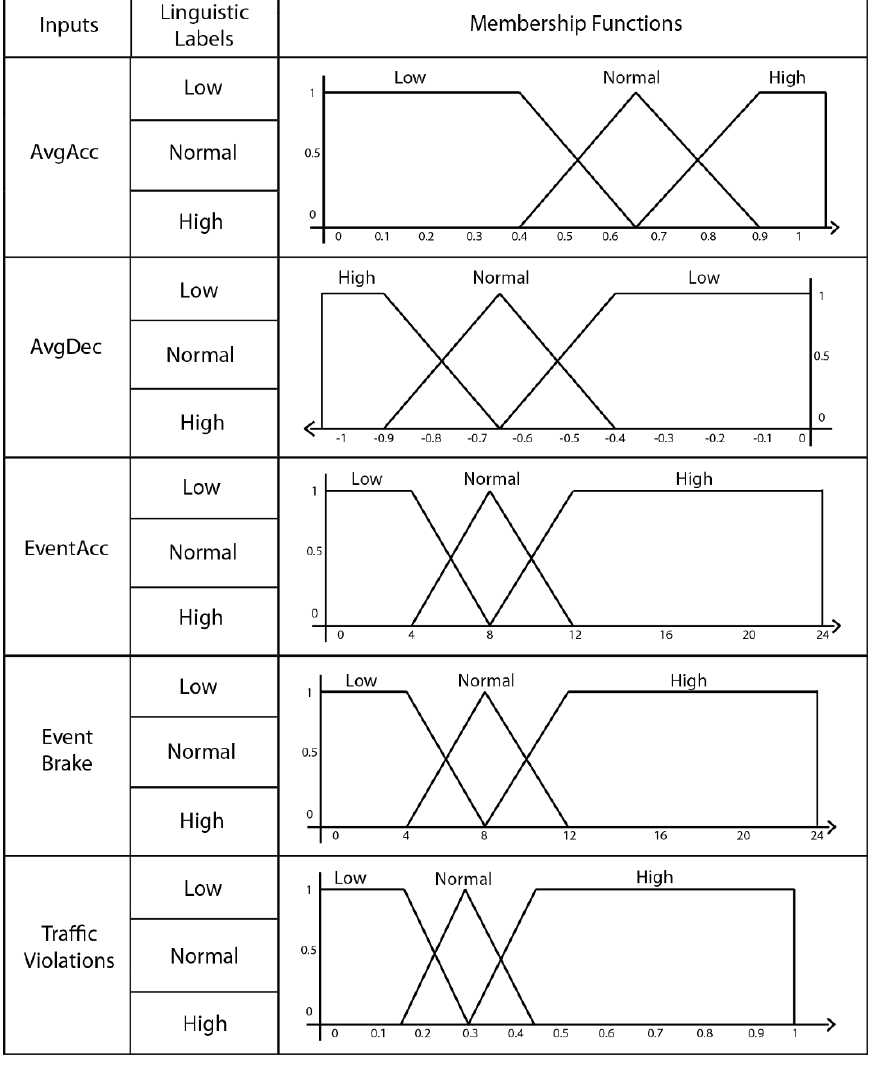
Figure 2. Input variables description with their linguistic labels and membership functions.